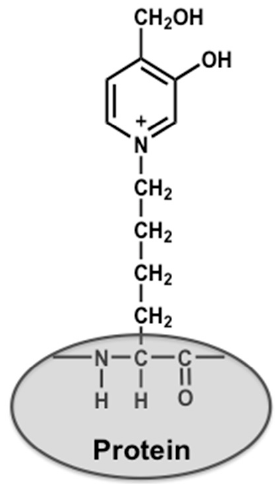
Figure 2. Chemical structure of GA-pyridine.